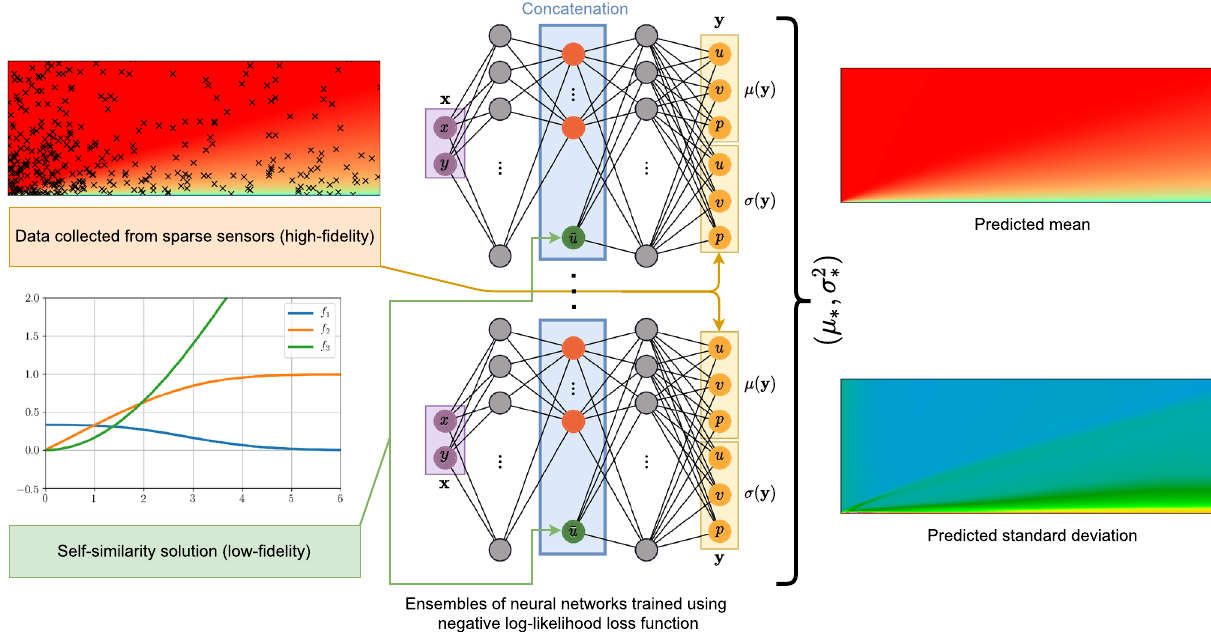
Figure 2. Illustration of the multi-fidelity data-fusion framework applied to the laminar flat plate boundary layer prediction task. The self-similarity Blasius solution is replaced by the one-seventh power law when applying to the turbulent boundary layer